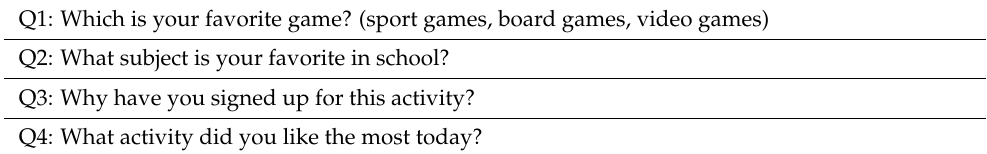
Table 12. Science, technology, engineering, and math (STEM)-related generic questions. Q1: Which is your favorite game? (sport games, board games, video